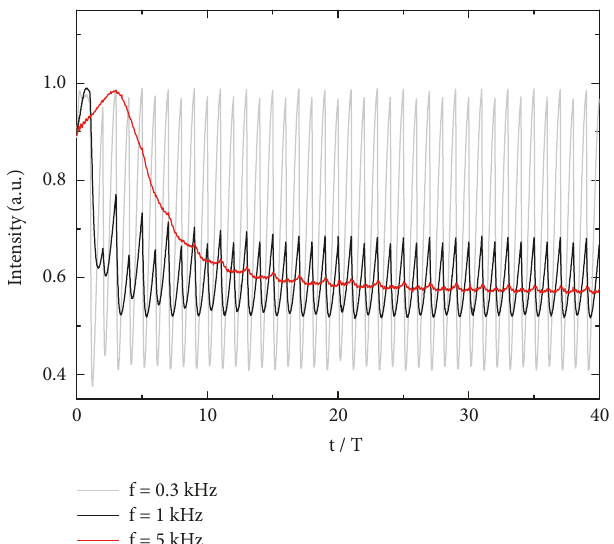
Figure 8: The dependence of a light intensity 𝐼 passed through the PET-5CB film as a function of the dimensionless time parameter 𝑡/𝑇 at different frequencies 𝑓 = 0.3. . .5 kHz of the applied electric field: 𝑇 = 1/2𝑓 ; the voltage 𝑈 = 170